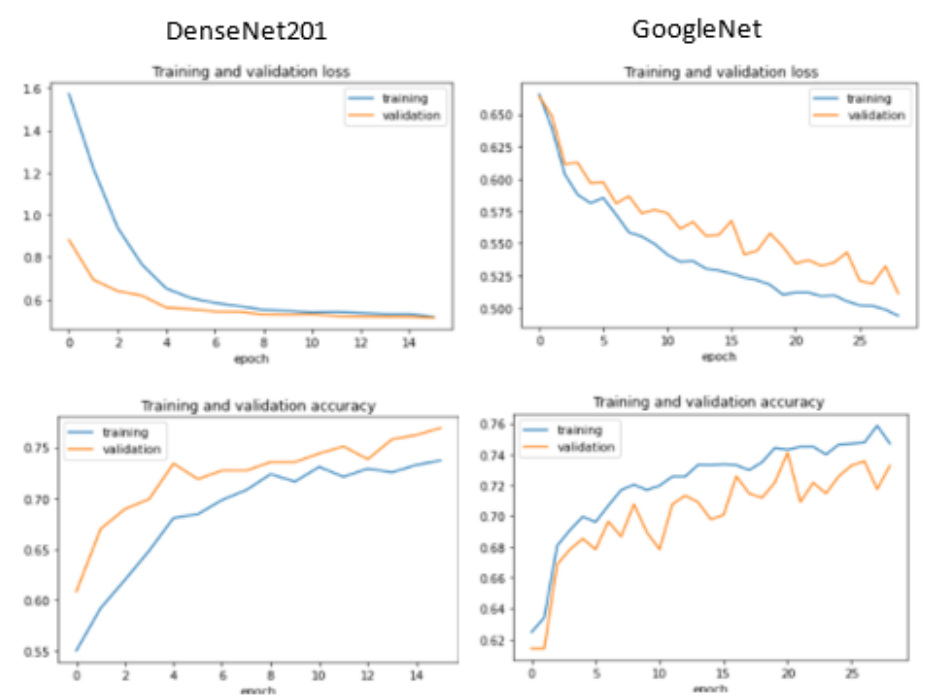
Figure 6. Training and validation performance for DenseNet 201 and GoogleNet.